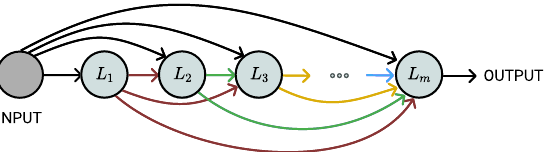
Figure 10. Dense connectivity. Instead of m (layer-wise) connections, m -layer densely connected ( m + 1 ) network has m layer-wise connections. 2 The architecture of densely connected network with 121 weight layers (excluding batch normalization layers), DenseNet121 , is shown in Figure 11.